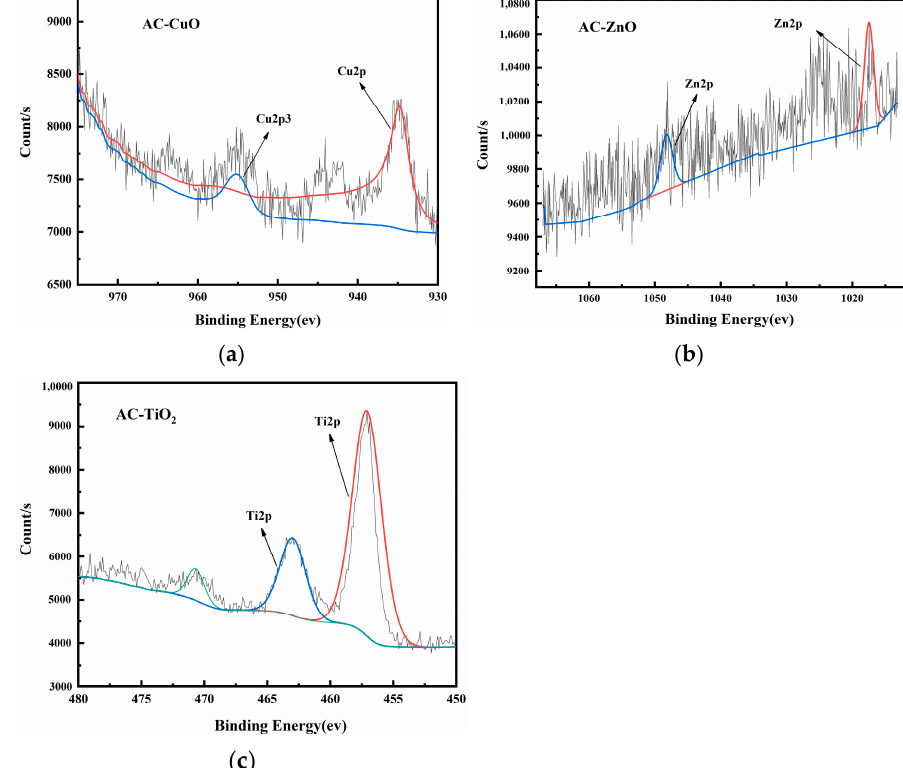
Figure 8. XPS spectra of ( a ) AC-CuO; ( b ) AC-ZnO; and ( c ) AC-TiO 2 .